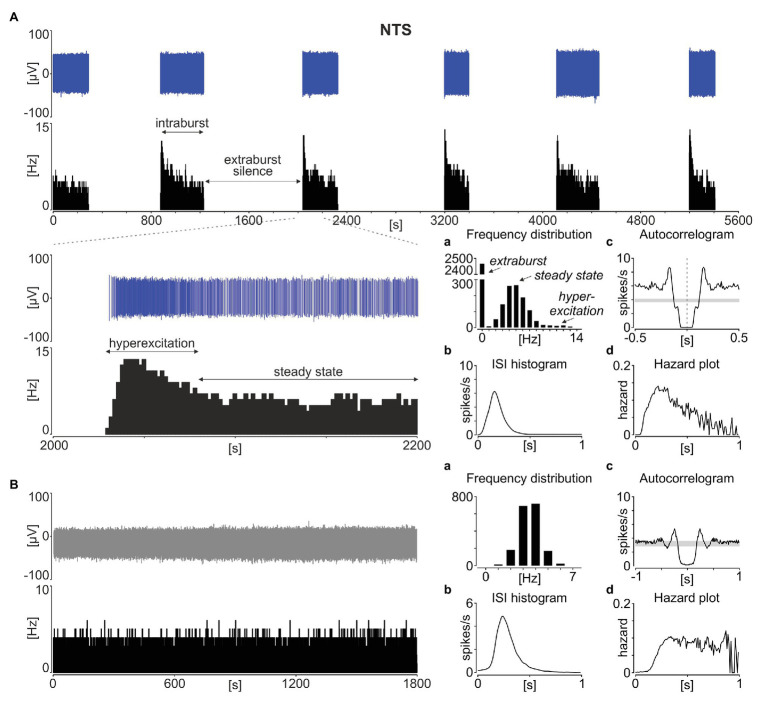
Phasic activity pattern in the rat nucleus of the solitary tract (NTS). (A) Spike sorted single units (in blue) with a corresponding firing rate histogram (bin: 1 s) showing a typical phasic activity in the NTS. The enlarged 200 s of the recording is shown below. (B) Example of tonic discharge. (a) The distribution of firing rates. (b) Inter-spike interval (ISI) histograms. (c) Autocorrelograms with the 95% CI depicted by the grey box. (d) The hazard plot showing the probability of an ISI after each spike. Bins in (a) are 1 Hz, while in (b–d) – 10 ms.